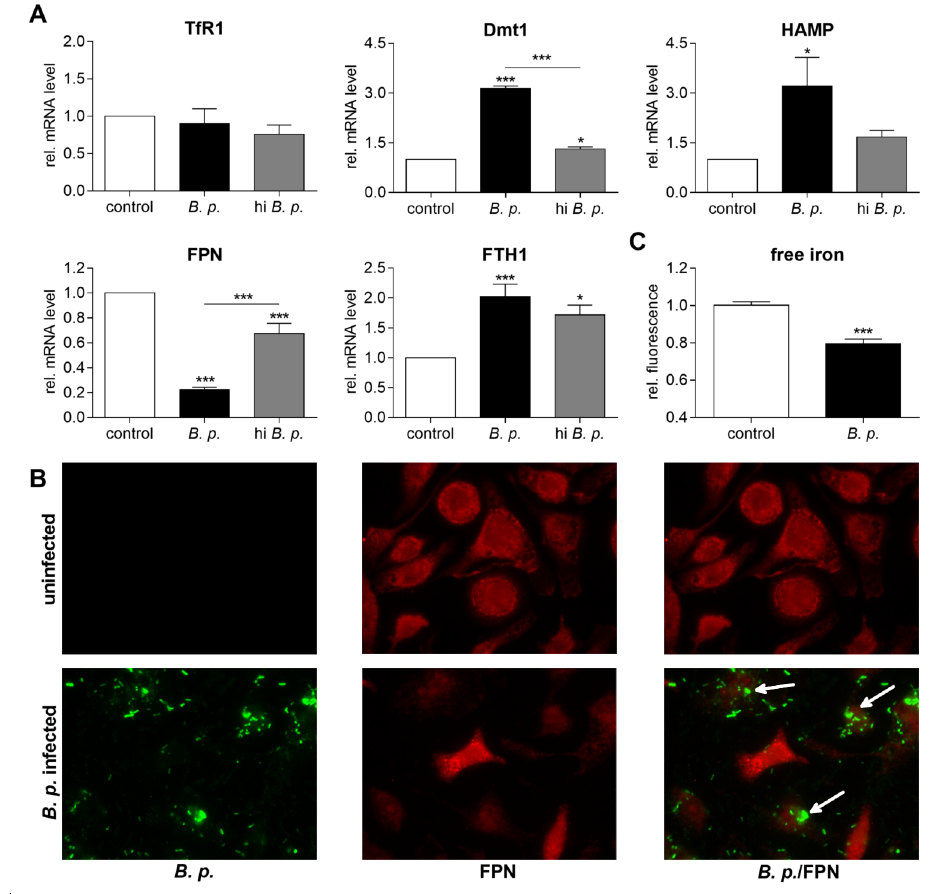
Fig 1. B . pseudomallei infection causes iron accumulation and ferritin upregulation in macrophages. (A) BMM were infected with live or heat-inactivated (hi) B . pseudomallei ( B . p .) at MOI 50 and harvested 24 hours after infection. RNA was analysed for gene expression of transferrin receptor (TfR1, n = 4), divalent metal transporter-1 (Dmt1, n = 3), hepcidin antimicrobial peptide (HAMP, n = 5), ferroportin (FPN, n = 7), and ferritin heavy chain 1 (FTH1, n = 6) by qRT-PCR. Data are expressed as mean with standard error of the mean (SEM). Comparison of groups was done using one-way ANOVA and Bonferroni post-hoc test ( (cid:3) p < 0.05, (cid:3)(cid:3)(cid:3) p < 0.001). (B) Expression of ferroportin (red) was examined by immunocytochemical staining after 24 hours in uninfected and B . pseudomallei infected (green) BMM (magnification x1000). In the overlay ( B . p ./FPN) white arrows indicate decreased expression of FPN solely in cells that have ingested bacteria. (C) Intracellular free iron levels were monitored after 24 hours in BMM following infection with B . pseudomallei using the cell-permeable fluorescent dye Phen Green SK, which is quenched upon binding iron and thus inversely related to the labile intracellular iron accumulation. Data are presented as mean with SEM of triplicate determinations (n = 6). Statistical analyses were conducted using Student’s t- test ( (cid:3)(cid:3)(cid:3) p < 0.001). pseudomallei 24 hours after infection (Fig 2B). Since hepatocytes have a large capacity for iron storage and are major producers of hepcidin, we also analysed the consequences of hepcidin administration in murine hepatoma Hepa1-6 cells. In line with macrophages, hepcidin led to higher bacterial load in hepatoma cells (Fig 2B). To exclude direct effects of hepcidin or vehicle on B . pseudomallei we performed growth kinetics in LB broth and M9 minimal medium. How- ever, bacterial growth was not affected by hepcidin in both media at 24 hours (Fig 2C). Thus, our results indicate that the hepcidin-mediated intracellular iron retention is beneficial for the establishment of B . pseudomallei infection in host macrophages.